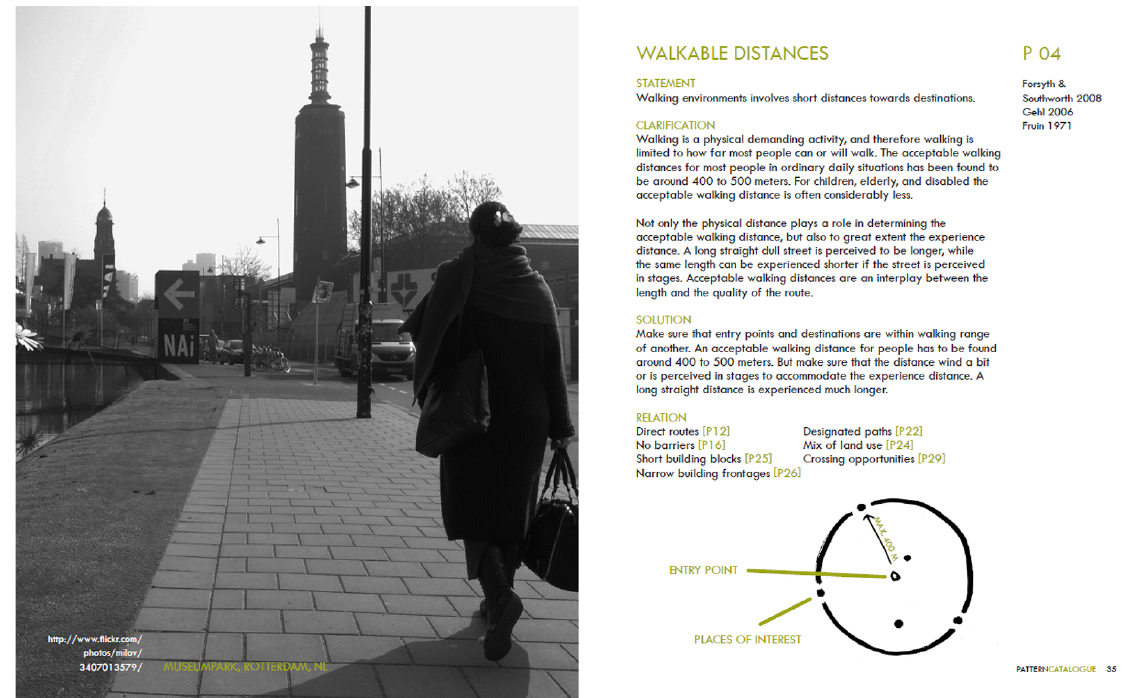
Figure 1. Example of a pattern (van Bellen, 2010b, pp. 34–35).